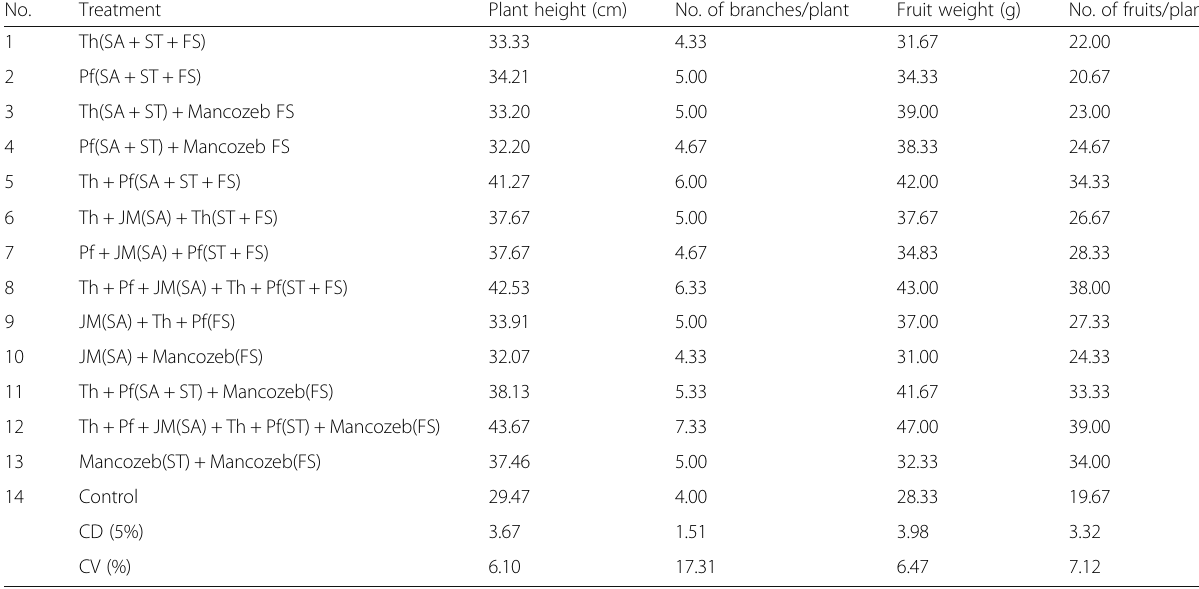
Table 2 Effect of biocontrol agents and arbuscular mycorrhizal fungi on plant growth promotion of tomato under field conditions at Vegetable Research Center during 2014 –